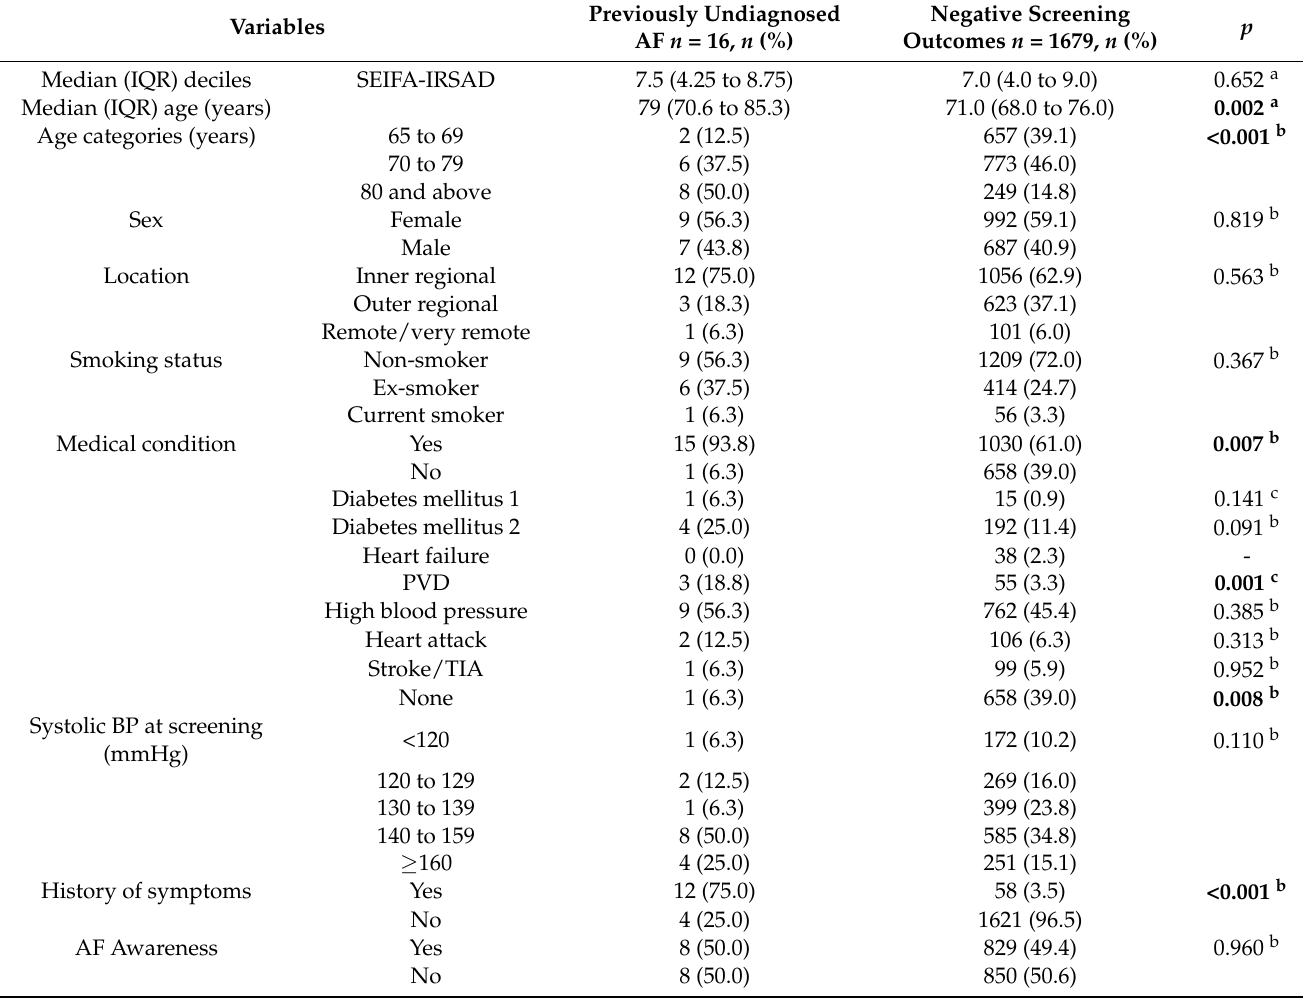
Table 3. Comparison of participants with previously undiagnosed AF and those with negative screening